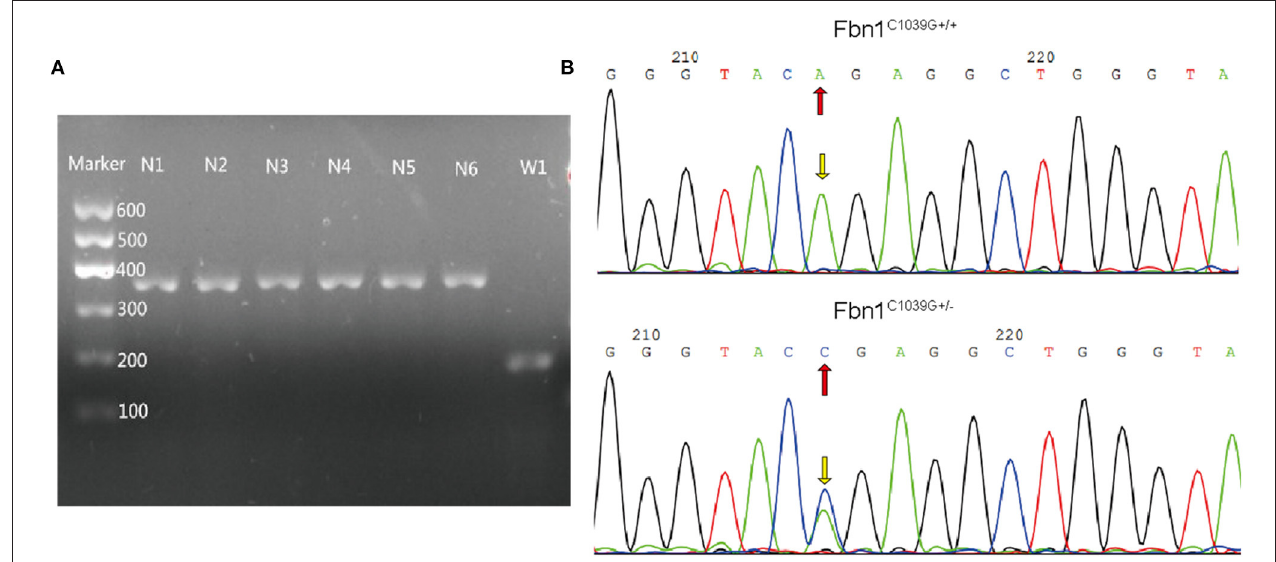
FIGURE 1 | Genotype identification. (A) Agarose gel electrophoresis was used to identify the genotypes of LDLR − / − mice. The length of the LDLR − / − product was 350 bp, while that of the LDLR + / + product was 167 bp. (B) Gene sequencing analysis showed that Fbn1 C1039G + / − had a bimodal waveform, with the nucleotide mutated to C, while Fbn1 C1039G + / + only had a single waveform, and the nucleotide was still